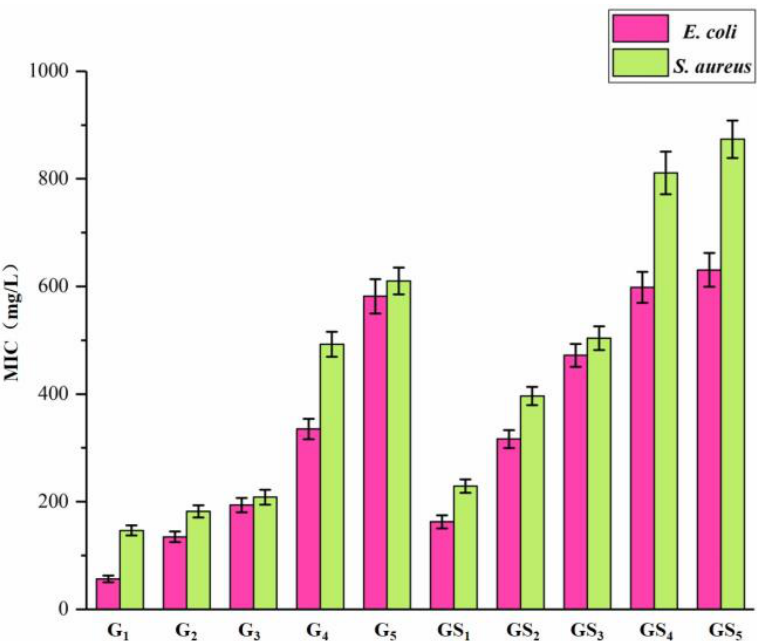
Figure 10. MIC of purified compounds from DHP against E. coli and S. aureus . Legend: MIC: the minimum inhibitory concentration.